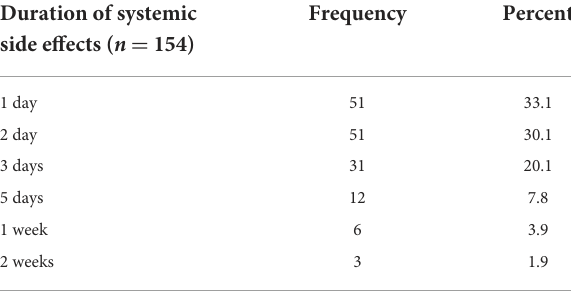
TABLE 11 Duration of systemic side effects of COVID-19 vaccines among healthcare workers in Ethiopia, 2021. Duration of systemic